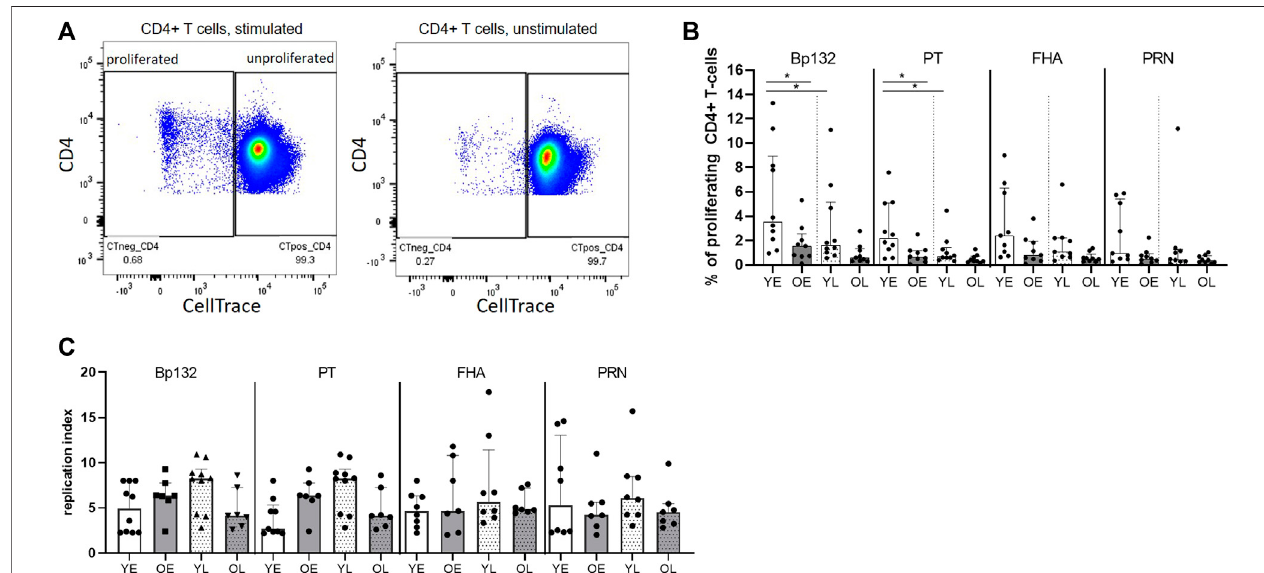
FIGURE5| ReducedproliferativeresponseofBp-speci fi cCD4 + Tcellsatolderage.PBMCsofyoungsters(Y)andolderadults(O)ofearly(E)andlate(L)timepoints were labelled with a proliferation dye and subsequently assessed on sequential halving of fl uorescent intensity after 6-days stimulation Bp peptide pools Bp132, PT S1 (shown as PT), FHA, and PRN. (A) Gating strategy ofproliferating and non-proliferating CD4 + T cells as shown for Bp132 peptidepool-stimulated (left plot) and medium (unstimulated) (right plot) conditions. (B) Frequencies of proliferating CD4 + T cells post stimulation. (C) Replication index. Dots show background subtracted frequenciesofindividualcases,whilebarsrepresentmediansandinterquartilerangeyoungsters(Y),whitebars;olderadults(O),darkbars;early(E)phasesamples,open bars; late(L) phasesamples,dottedbars,asindicated.Statisticalsigni fi cance wascalculatedwithMann Whitney U -test andWilcoxonmatched pairs signed-rank test. * (cid:1) p <